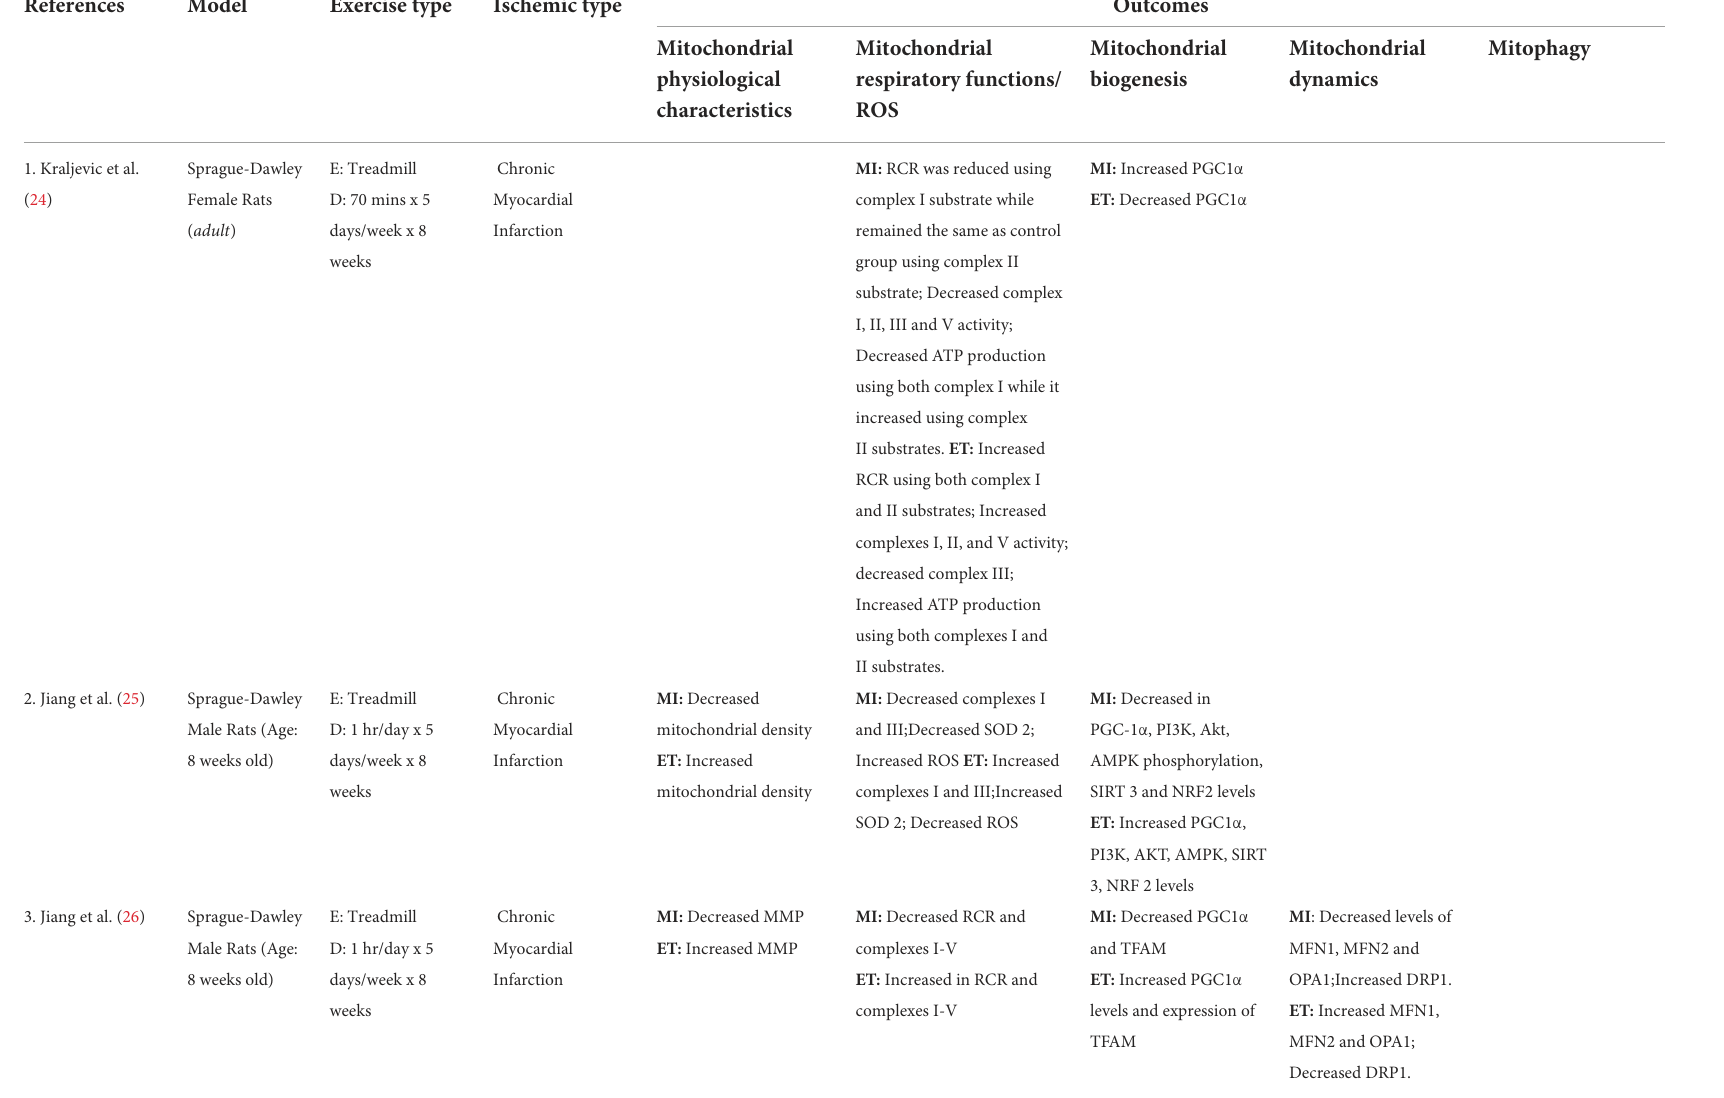
TABLE 2 Effects of ischemia and exercise training on the cardiac mitochondrial physiological characteristics (MPC) and cardiac mitochondrial respiratory